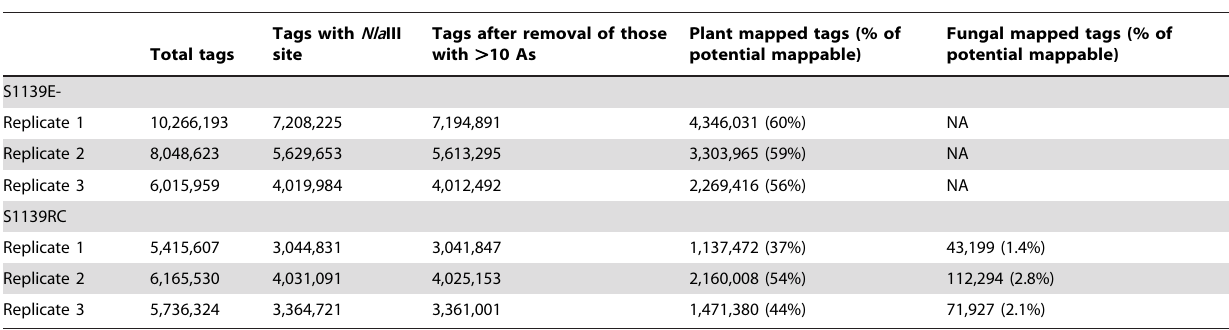
Table 2. Characteristics of the SOLiD-SAGE tags.